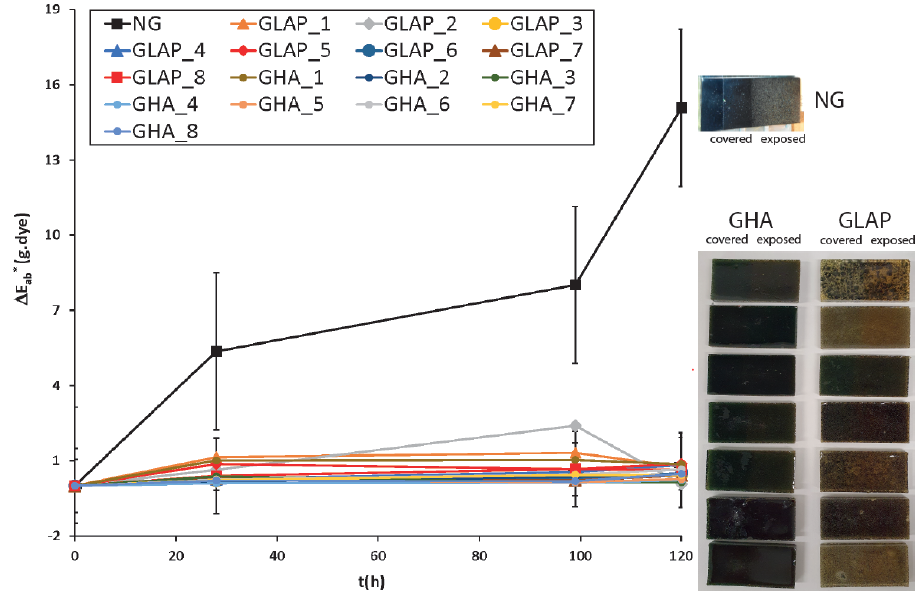
Figure 16. TGA–DTA diagram of halloysite (HA), chlorophyll (G) and the synthesized hybrid pigments GHA for the different conditions [1_8].